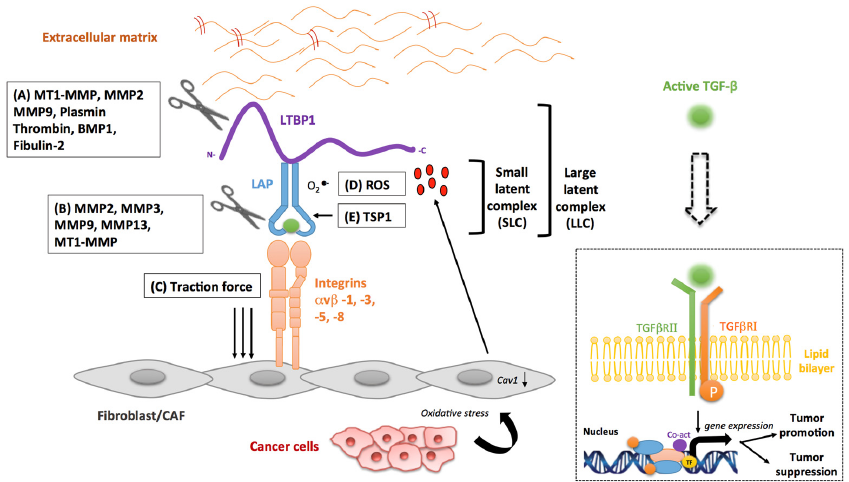
Figure 3. Stromal activators of TGF ‐β in the tumor microenvironment. ( A ) MT1 ‐ MMP,